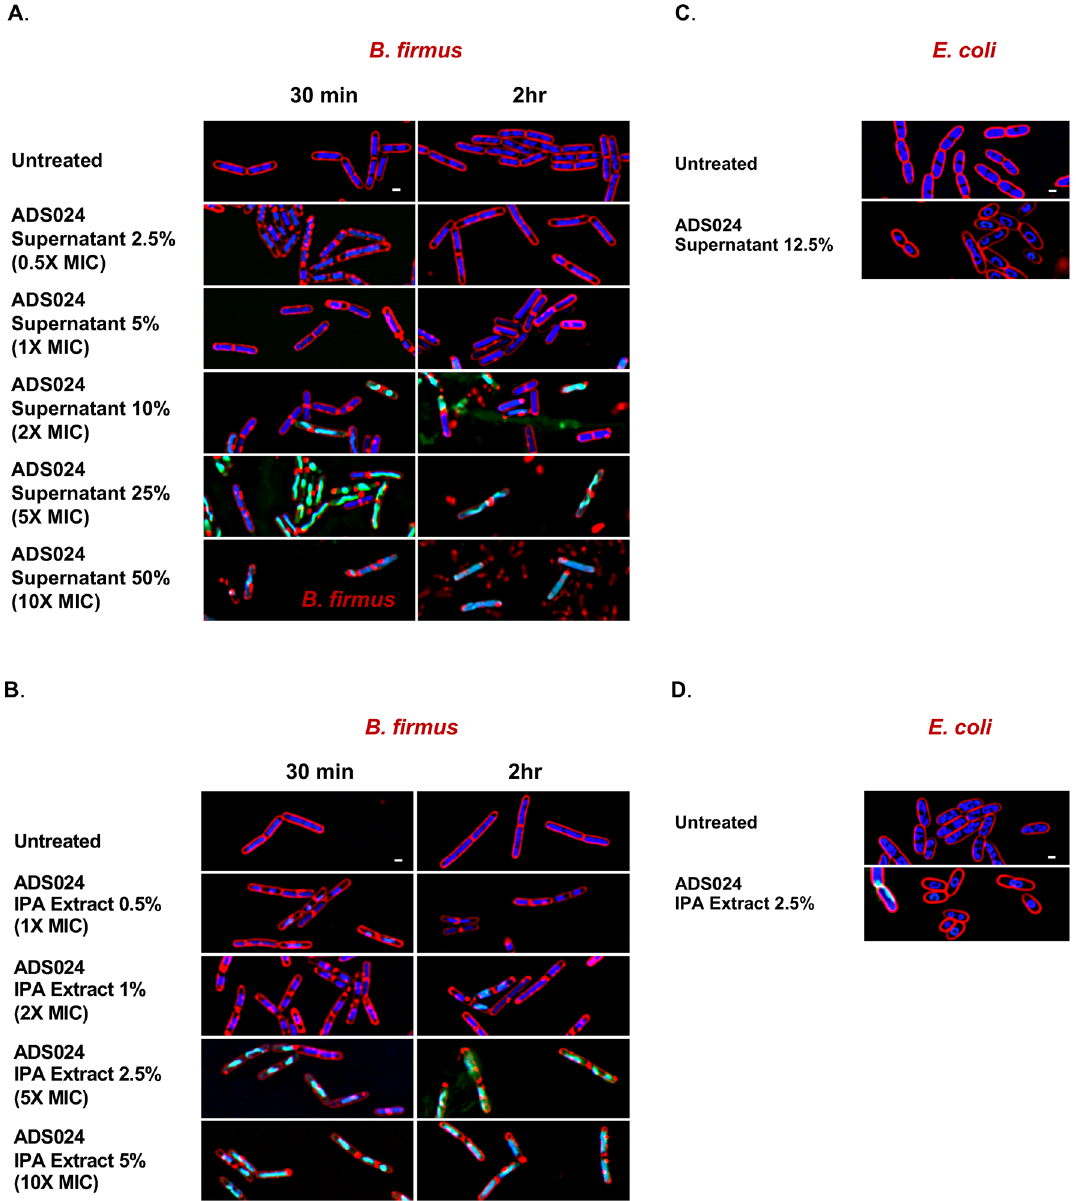
Figure 8. ADS024 CFS and IPA extracts can inhibit translation and disrupt B. firmus cell membranes. ( a ) B. firmus was incubated with ADS024 CFS for 30 min and 24 h, and bacterial cytological profiling was used to visualize morphological changes. B. firmus cell membranes are shown in red, and B. firmus DNA is shown in blue. SYTOX Green fluorescence indicates permeabilization of the B. firmus cell membrane. ( b ) Similar experiment as in ( a ) except that ADS024 IPA extracts were used. ( c ) Similar experiment as in ( a ) except that E. coli was used in place of B. firmus. ( d ) Similar experiment as in ( c ) in which E. coli was exposed to ADS024 IPA extracts. White scale bar for all images is 1 micron. Experiments were conducted in